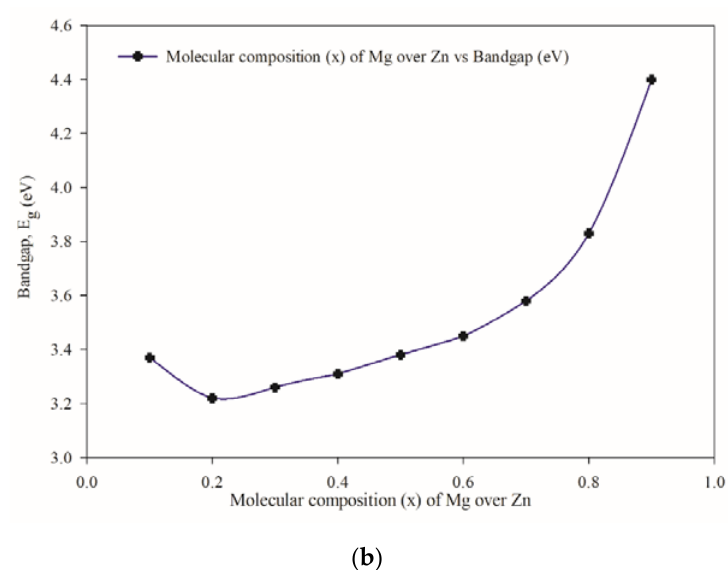
Figure 8. The optical properties of the samples: ( a ) (αhν) 2 plotted against hν; ( b ) the bandgap variation with respect to Mg concentration.